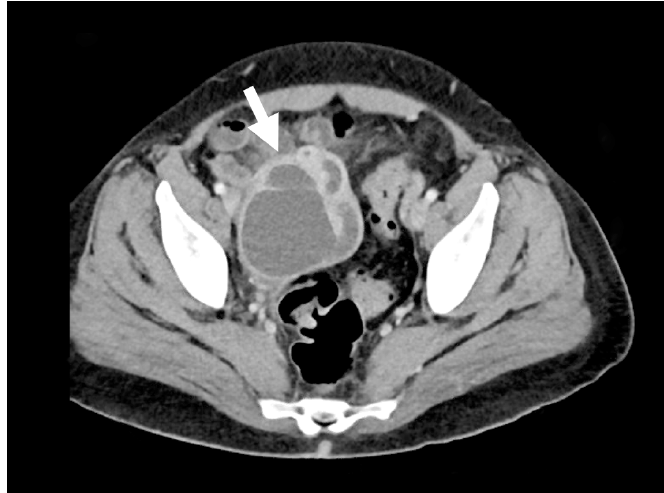
Figure. The computed tomography finding which confirmed the